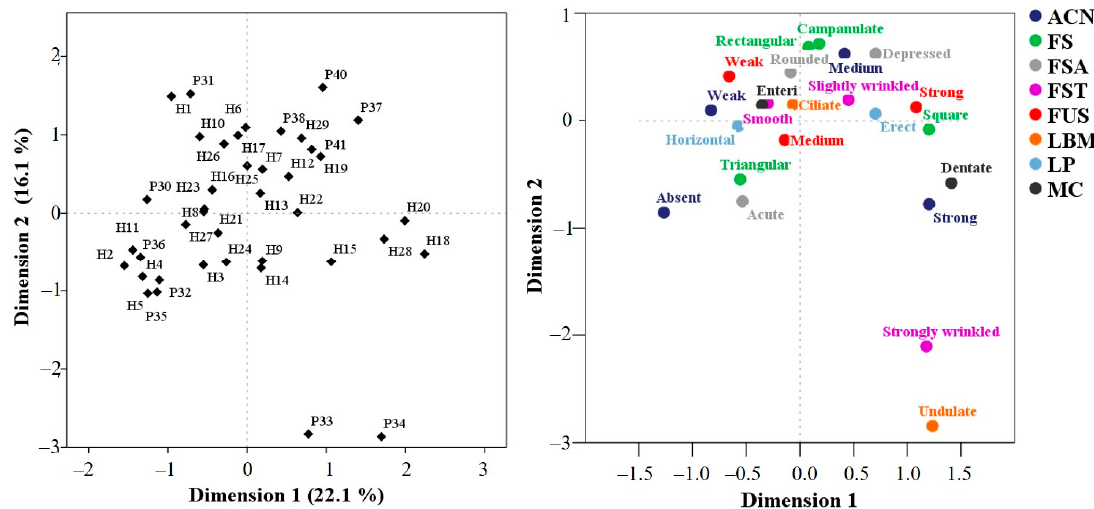
Figure 2. Distribution of the assessed F1 lines and progenitors, as well as the modalities of the main traits contributing to the axes 1 and 2, observed from the multiple correspondence analyses (MCA).